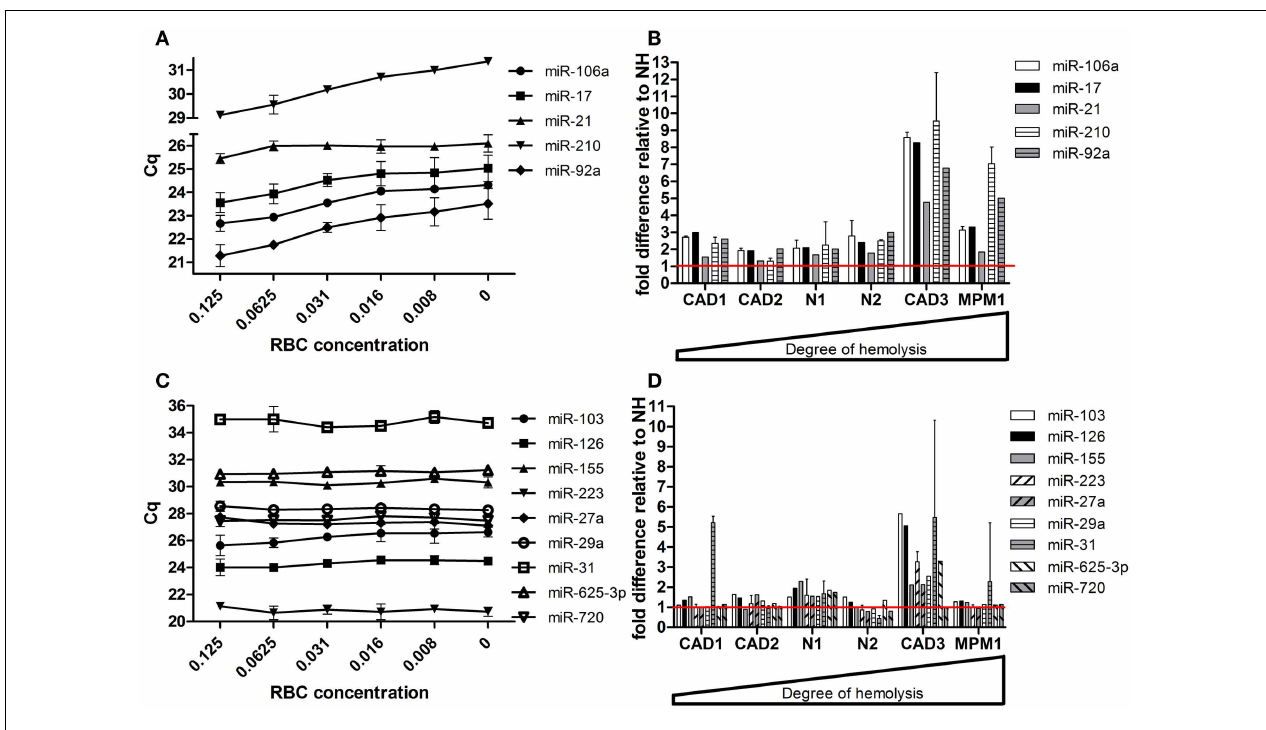
remained unaffected by increasing hemolysis in both the dilution series (C) and the matched pairs (D) .The red line represents the relative expression of the corresponding non-hemolyzed samples. Data are presented as raw Cq value ± SD (A,C) or relative microRNA level ± SD (B,D)